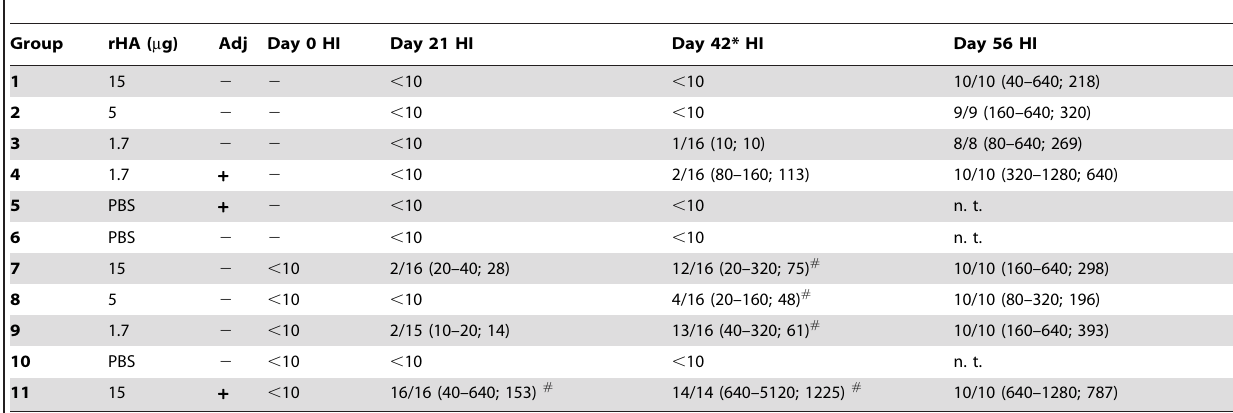
Table 3. Hemagglutination inhibition activity against homologous virus post-vaccination and post-challenge.